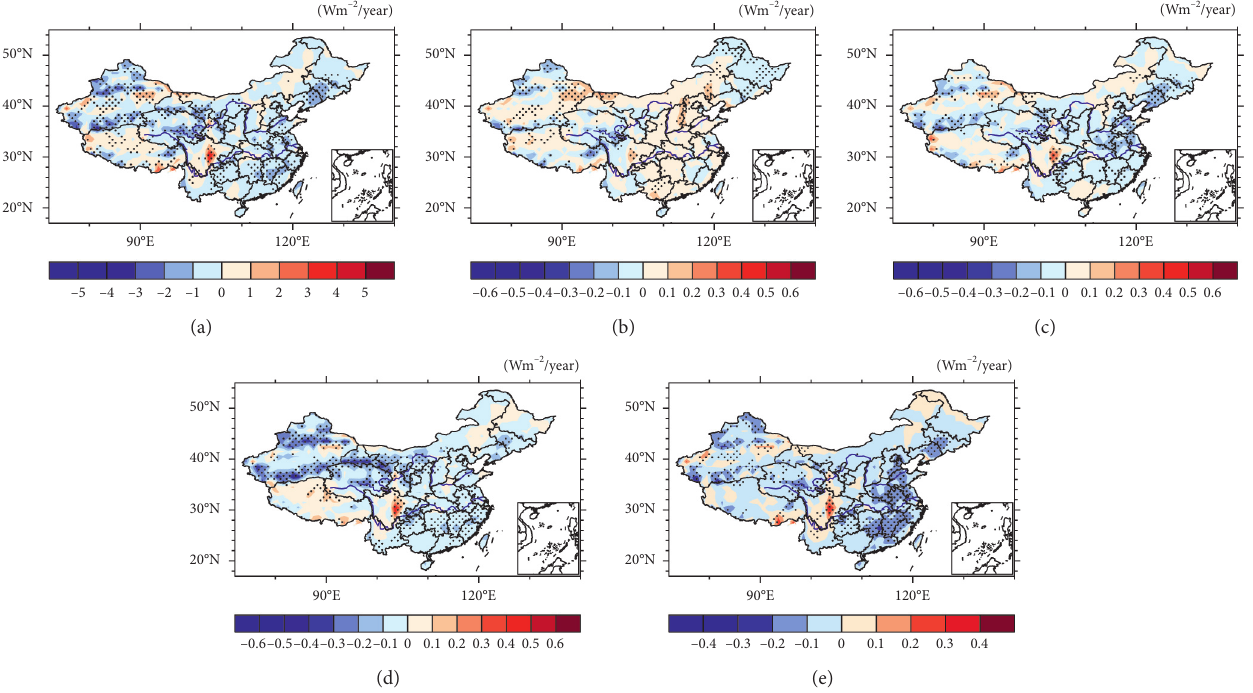
Figure 3: Distribution of annual and seasonal linear LER trends (Wm − 2 ) in China under all-sky conditions during 2001–2016 (dot regions indicate that linear trends attained the 95% significance level): (a) annual, (b) spring, (c) summer, (d) autumn, and (e) winter.